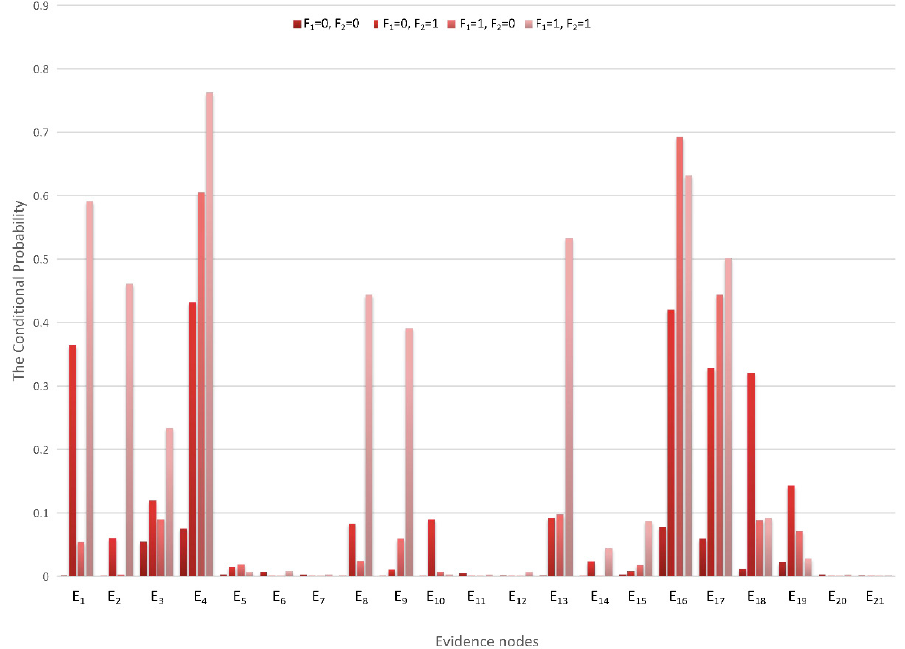
Figure 7. Conditional probability distribution diagram.